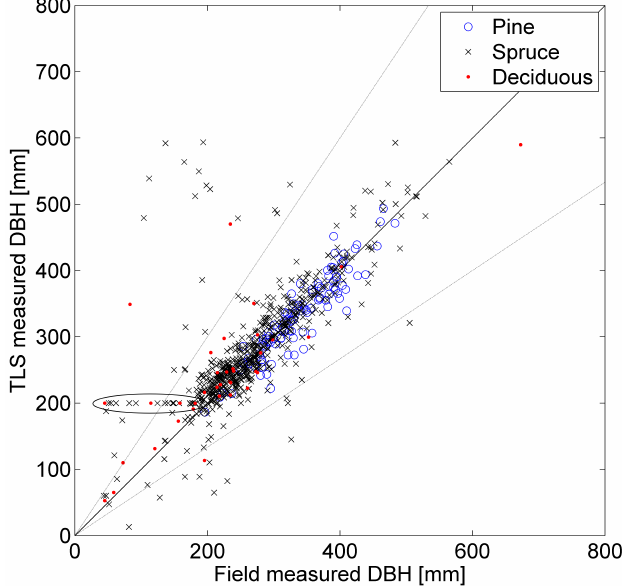
Figure 9. Scatterplot for TLS estimated versus field measured diameter at breast height (DBH). All points outside the dotted lines were denoted as outliers. For the points at DBH = 200 mm, inside the ellipse, the RANSAC algorithm was not able to give any results and therefore the values were set to the diameter class obtained by the Hough transform.